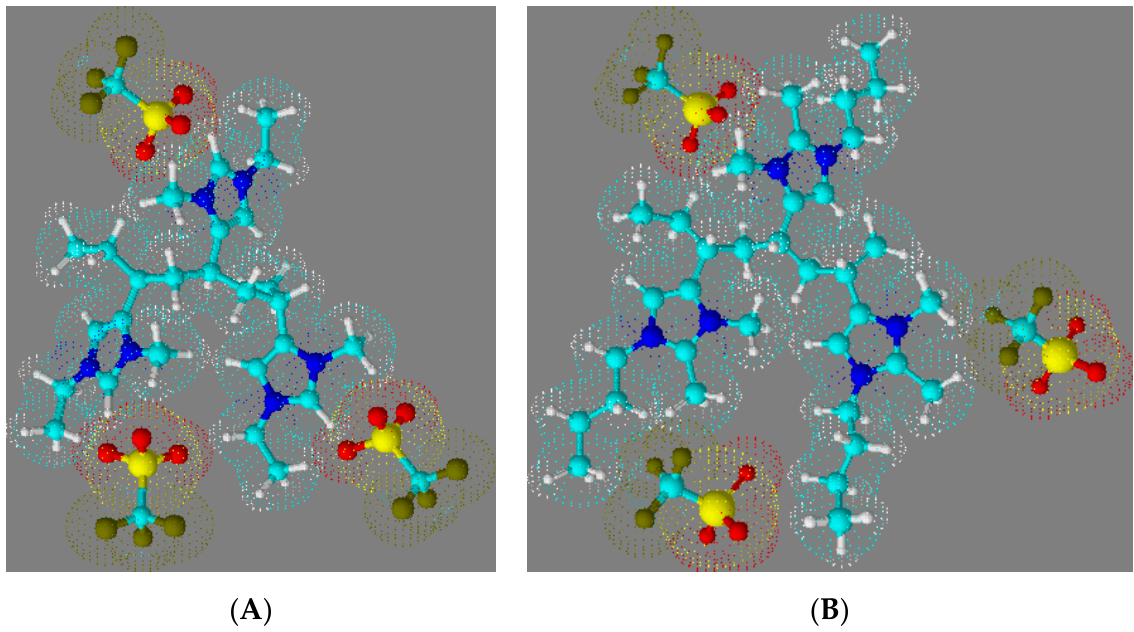
Figure 9. Space-filling molecular renderings of ( A ) 1-ethyl-3-methyl-4-vinylimidazolium triflate and ( B ) 1-butyl-2,3-dimethyl-4-vinylimidazolium triflate polymer triads .